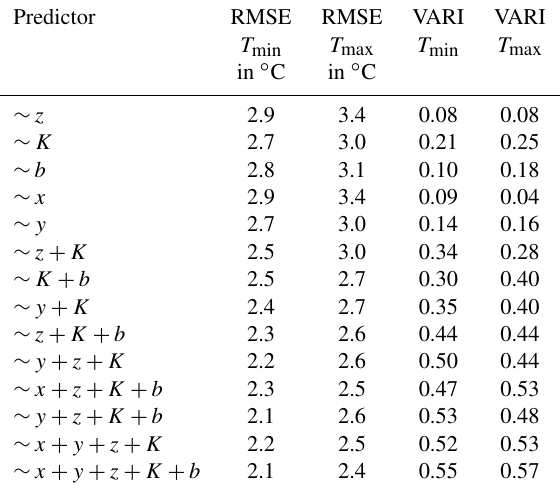
Table 1. RMSEs and VARI averaged over first year of the inter- polation period (September 2014–August 2015). Predictors: eleva- tion ( z ), continentality index ( K ), zonal mean temperature ( b ), lon- gitude ( x ), latitude ( y